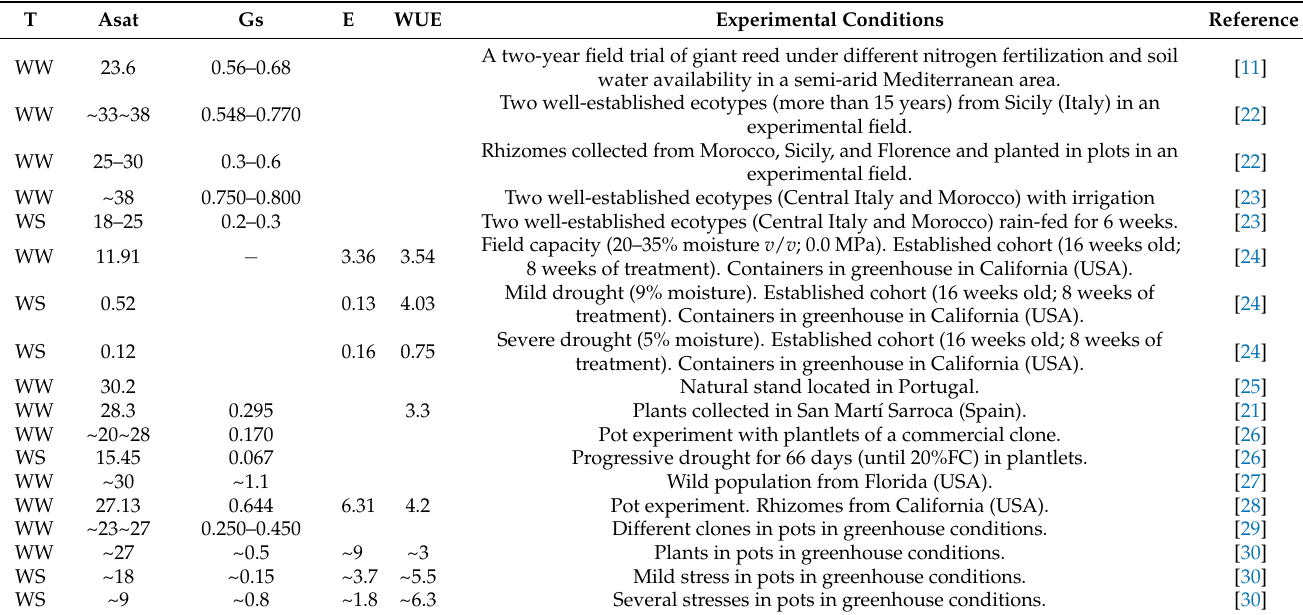
Table 1. Photosynthetic assimilation rate (A sat ; µ mol CO 2 m − 2 s − 1 ), stomatal conductance (Gs; mol m − 2 s − 1 ), transpiration rate (E; mmol m − 2 s − 1 ) and water use efficiency (WUE; µ mol mmol − 1 ) of different A. donax L. ecotypes growth in different treatments (T): (i) control conditions (well-watered, WW) and (ii) under water stress